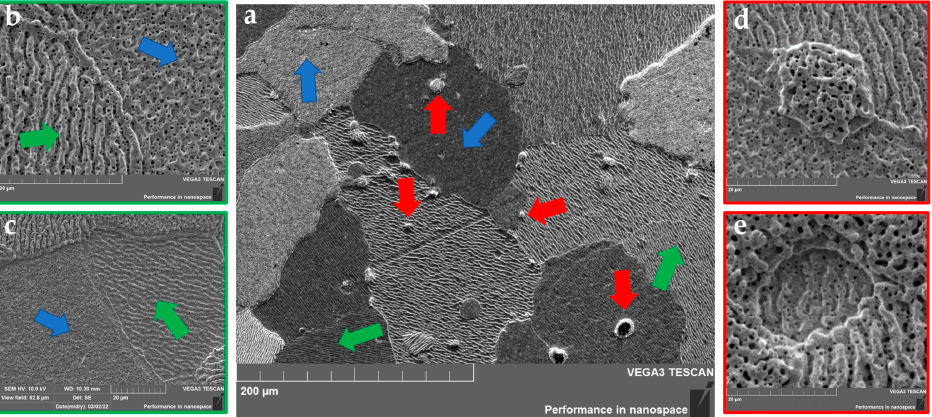
Figure 6. Microstructure of sample No. 2 surface after irradiation with helium plasma at ~1750 °C (red arrows indicate formed helium blisters, blue arrows indicate grains with extended oriented protrusions, green arrows indicate grains with a bumpy structure). ( a ) – coral structure; ( b ) and ( c ) – changes in morphology in grains; ( d ) and ( e ) – helium blisters.